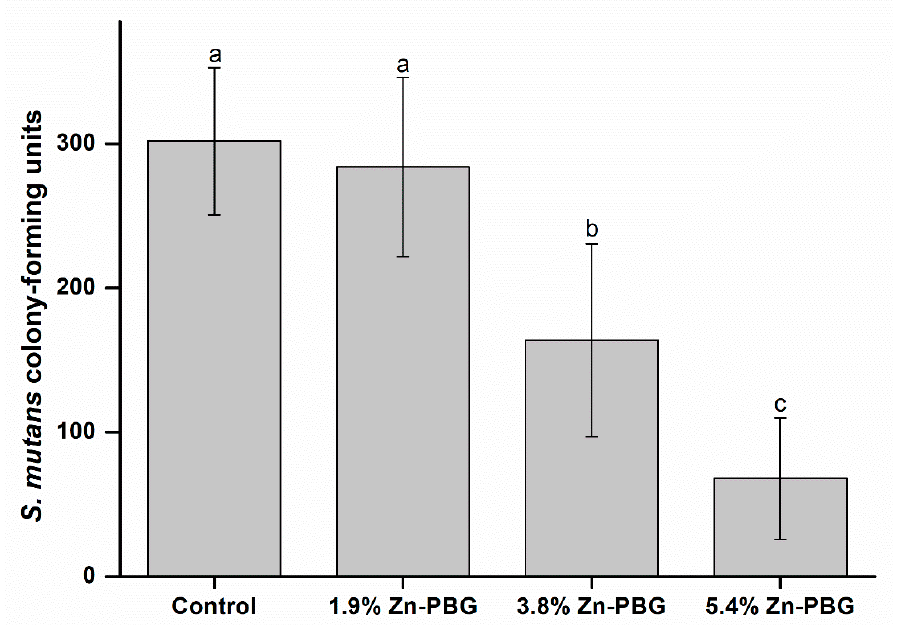
Figure 6. CFU counts for S. mutans on sample surface.